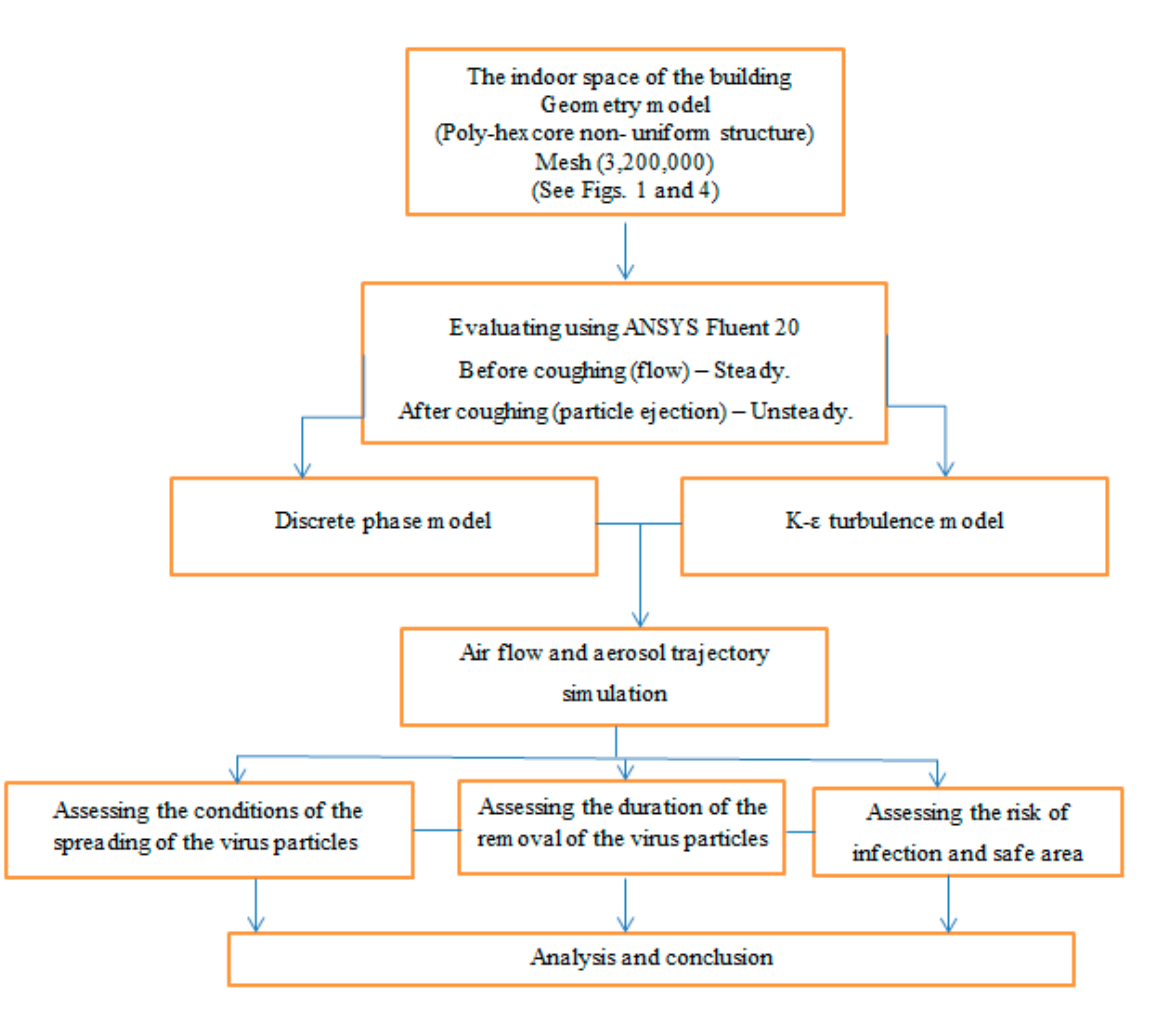
Figure 9. Modeling and the sequence of calculations.